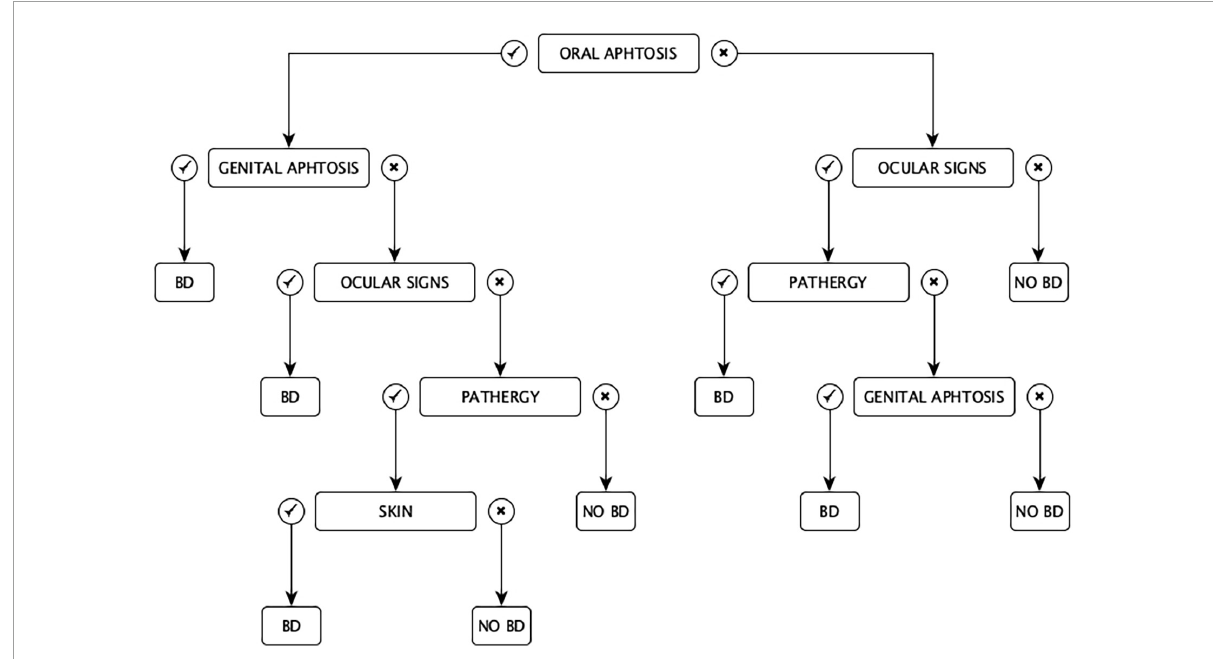
FIGURE2 Iranian “classification tree” criteria for Adamantiades-Behçet disease.